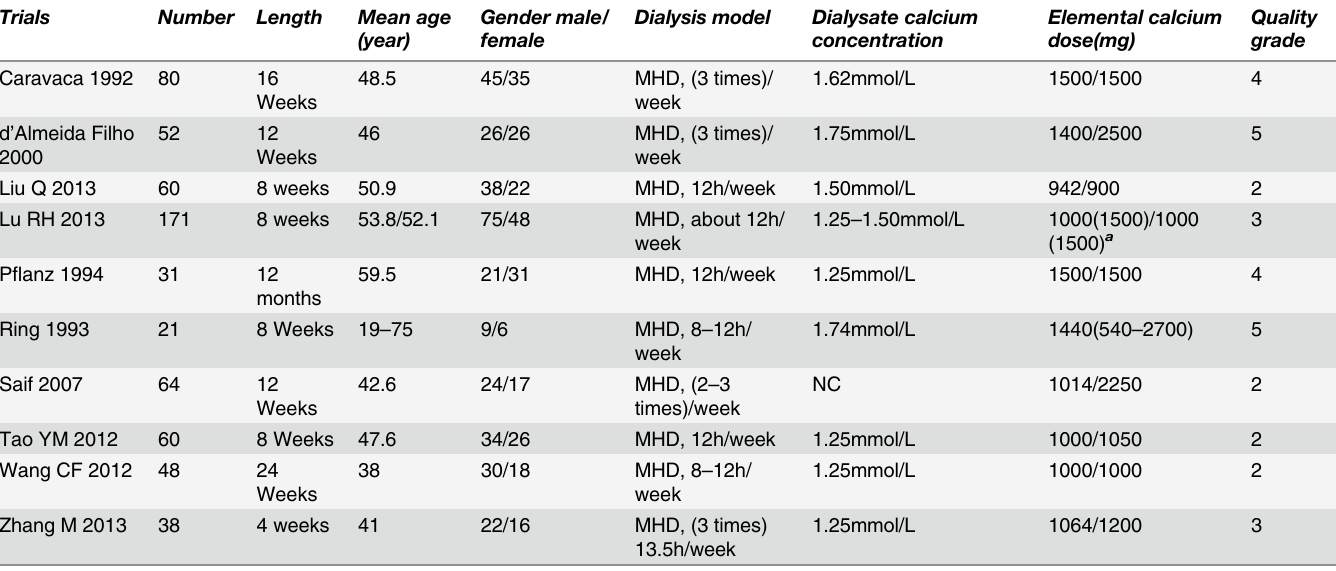
Table 1. Characteristics of the included trials.